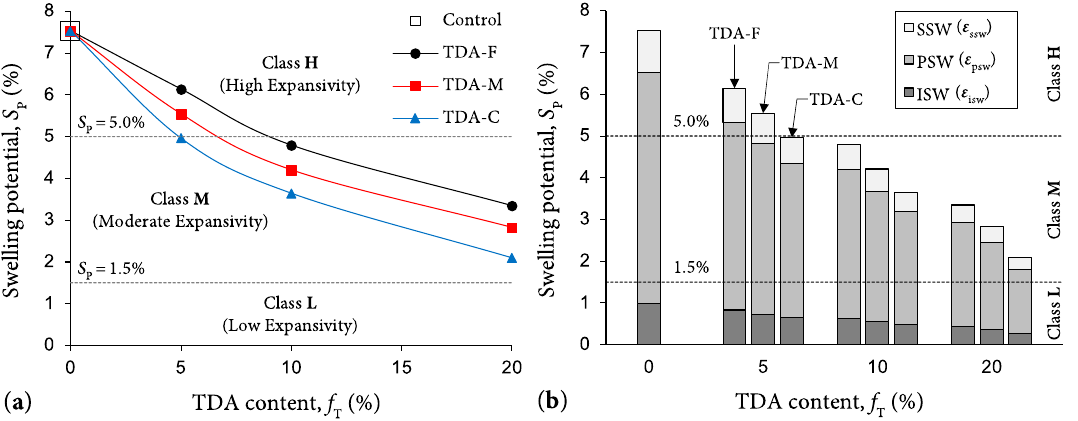
Figure 5. Variations of axial swelling strain against TDA content f T for the tested mix designs: ( a ) Ultimate swelling strain (i.e., swelling potential S P ); and ( b ) Initial, primary and secondary swelling strains (i.e., ε isw , ε psw and ε ssw ).